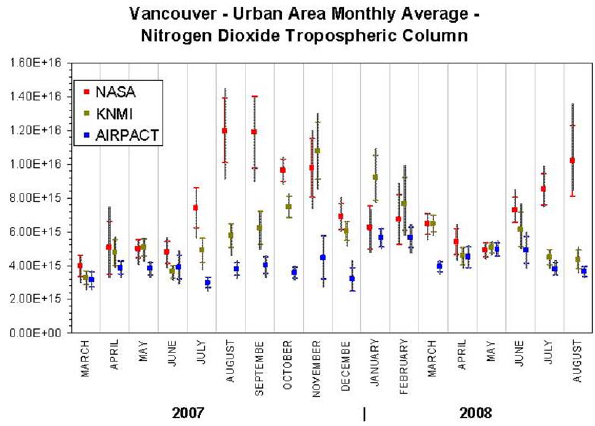
Fig. 6. Monthly Average NO 2 for Portland, Oregon over 18 months. The bars show standard deviation of spatial variation over a 1152km 2 area (8 AIRPACT pixels) while the whiskers show the extent of the maximum and minimum. Values are in molecules per square centimeter.